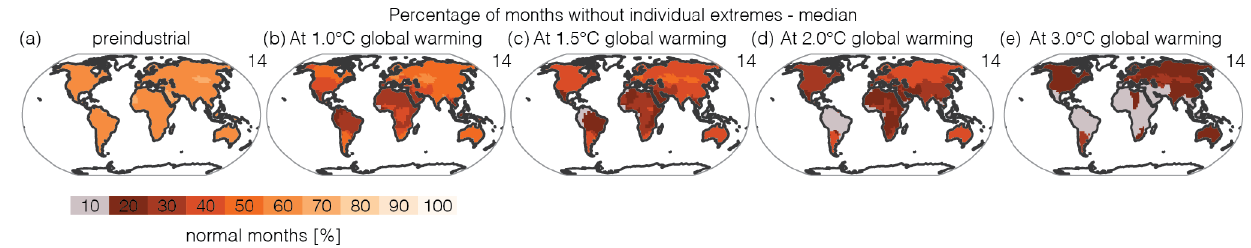
Figure 8. Percentage of non-event months (months without individual extremes) at warming levels ( + 1, + 1.5, + 2 and + 3 ◦